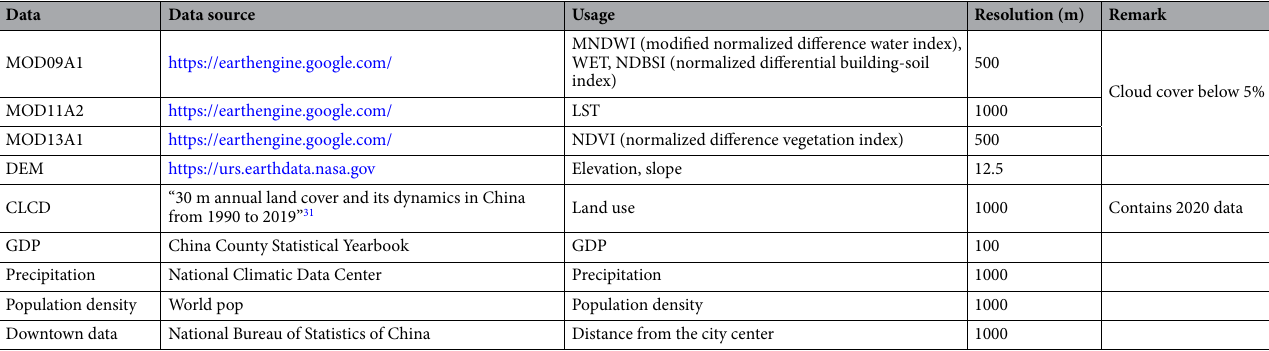
Table 1. Data source and